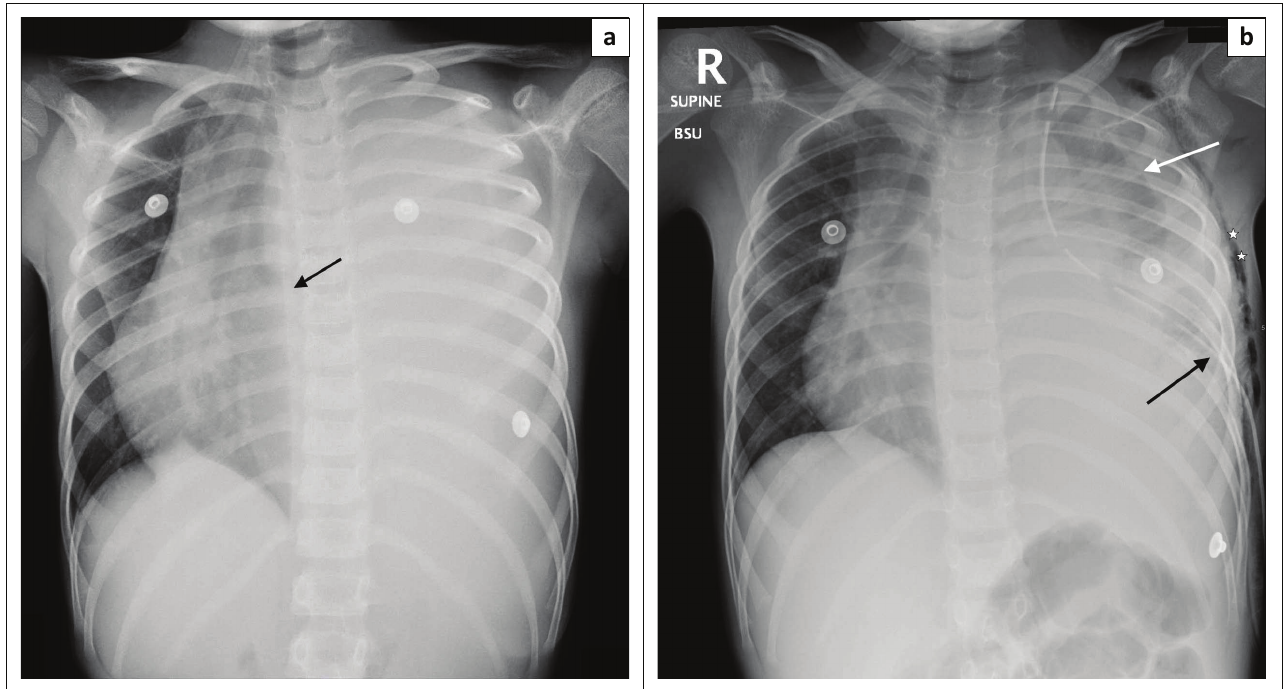
FIGURE 1: Frontal chest radiograph (CXR): (a) Initial CXR on presentation demonstrates complete opacification of the left hemithorax with resultant mediastinal shift to the right and cut-off of the left main bronchus (black arrow); (b) CXR post left chest wall/pleural biopsy. Left pneumothorax (white arrow) with the left intercostal drain in-situ (black arrow). Associated surgical emphysema of the left chest wall (white